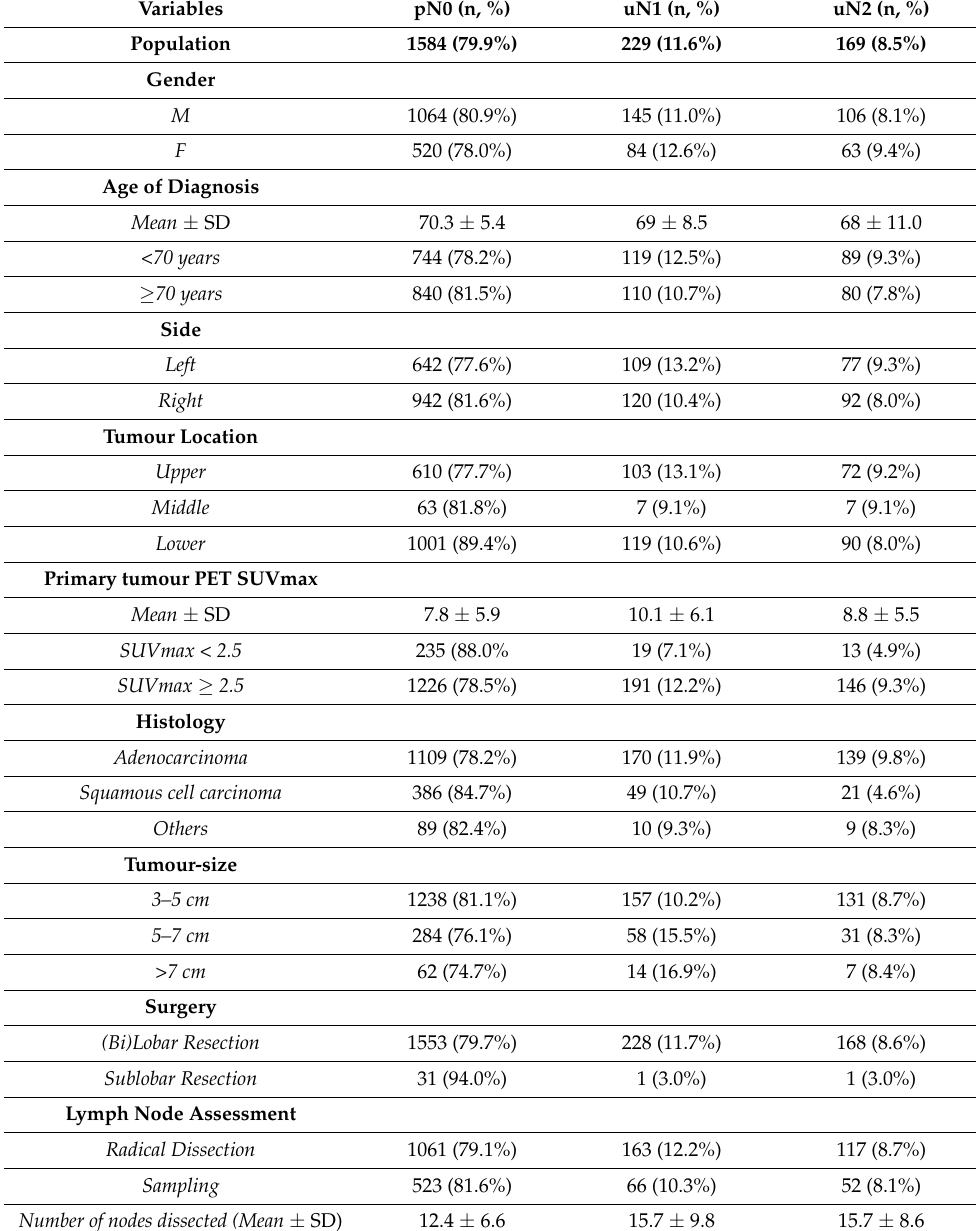
Table 2. The distribution of p-N status according to clinic-pathological variables. In this table we describe the clinico-pathological characteristics in the different groups according to